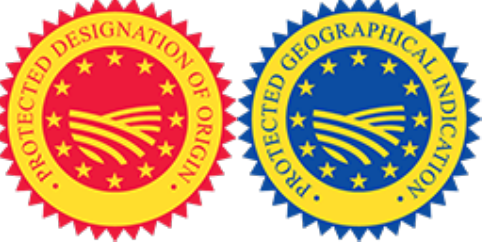
Figure 1. Geographical Indication (GI) marks: Protected Designation of Origin (PDO) mark and Protected Geographical Indication (PGI)